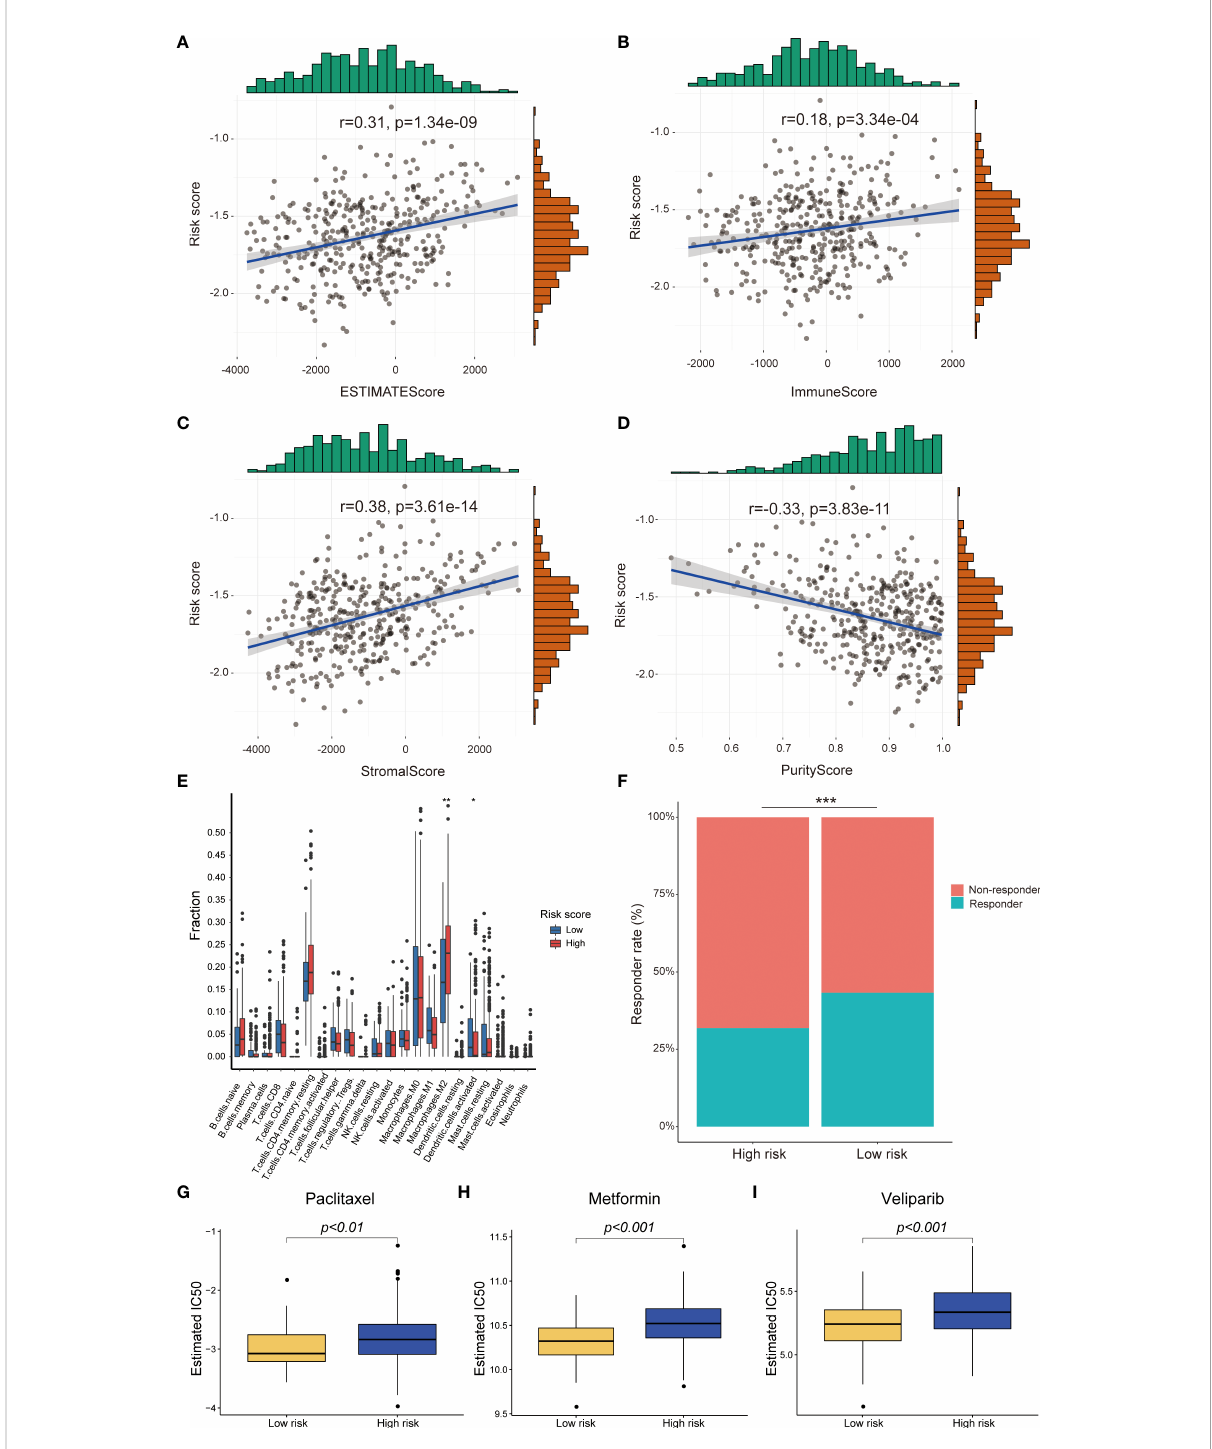
FIGURE 6 Difference between high-risk score group and low-risk score group in immune in fi ltration, immunotherapy and chemotherapy response prediction in TCGA-RNA-Seq cohort. The risk score was positively correlated with EstimateScore, ImmuneScore, StromalScore and negatively correlated with PurityScore (A-D) ; The different in fi ltrated fraction of 22 immune cells between high-risk group and low-risk group (E) ; The immunotherapy response of patients with OC in high- and low-risk subgroups (F) ; Estimated IC50 values indicated the chemotherapy response of paclitaxel, metformin and veliparib in TCGA-RNA-Seq cohort (G-I) . * p < 0.05 ; ** p < 0.01 ; *** p < 0.001